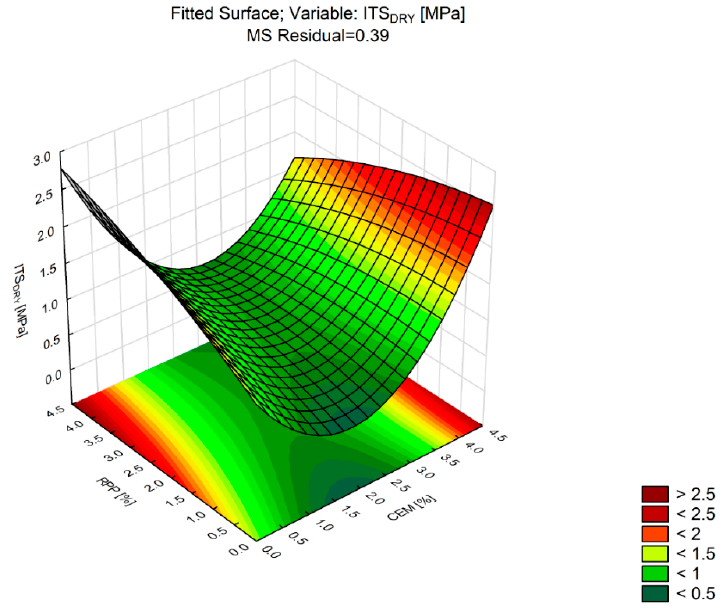
Figure 10. Response surface of ITS DRY versus RPP and CEM (CBM mixture).